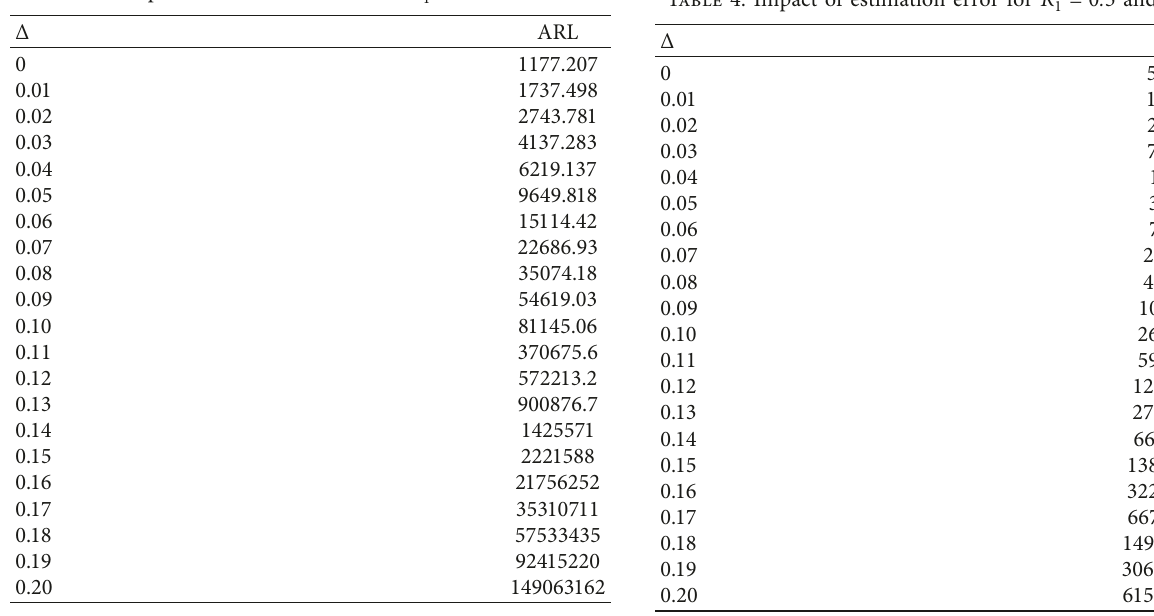
Table 2: Impact of estimation error for R